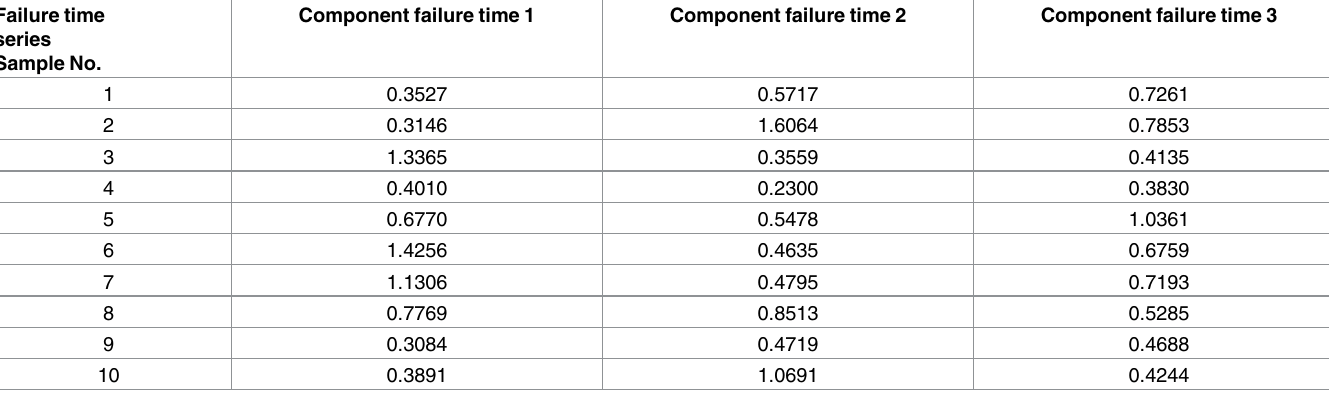
Table 4. Simulated data set for Weibull numerical